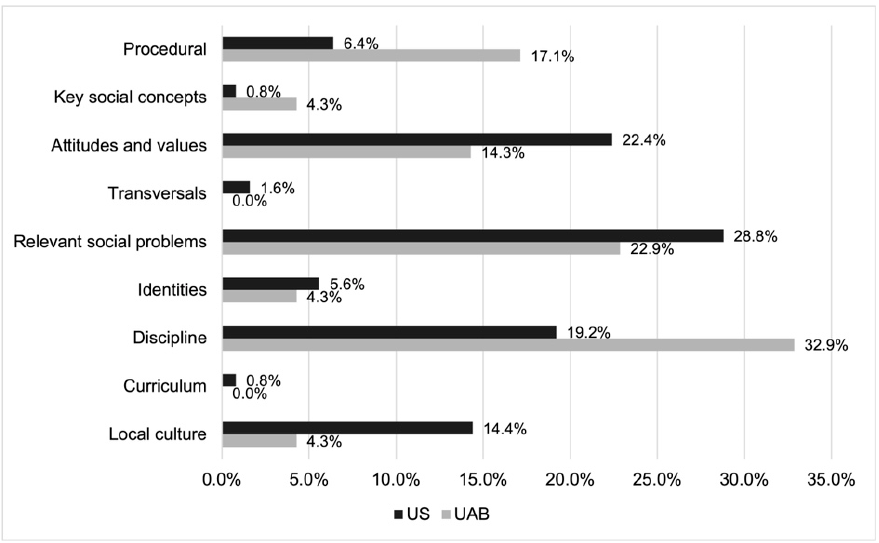
Figure 3. Types of